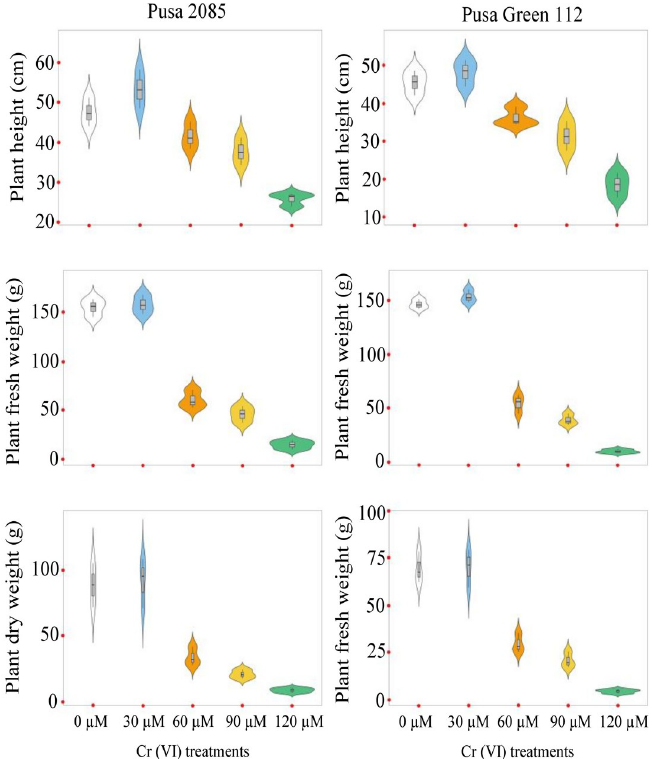
Fig 9. Violin plots showing the distributions of three plant growth parameters examined in two chickpea varieties, Pusa 2085 and Pusa Green 112, grown in pots under different chromium (Cr) concentrations. (a–b) plant height (PH) (cm). (c–d) plant fresh weight (PFW) (g). (e–f) plant dry weight (PDW)